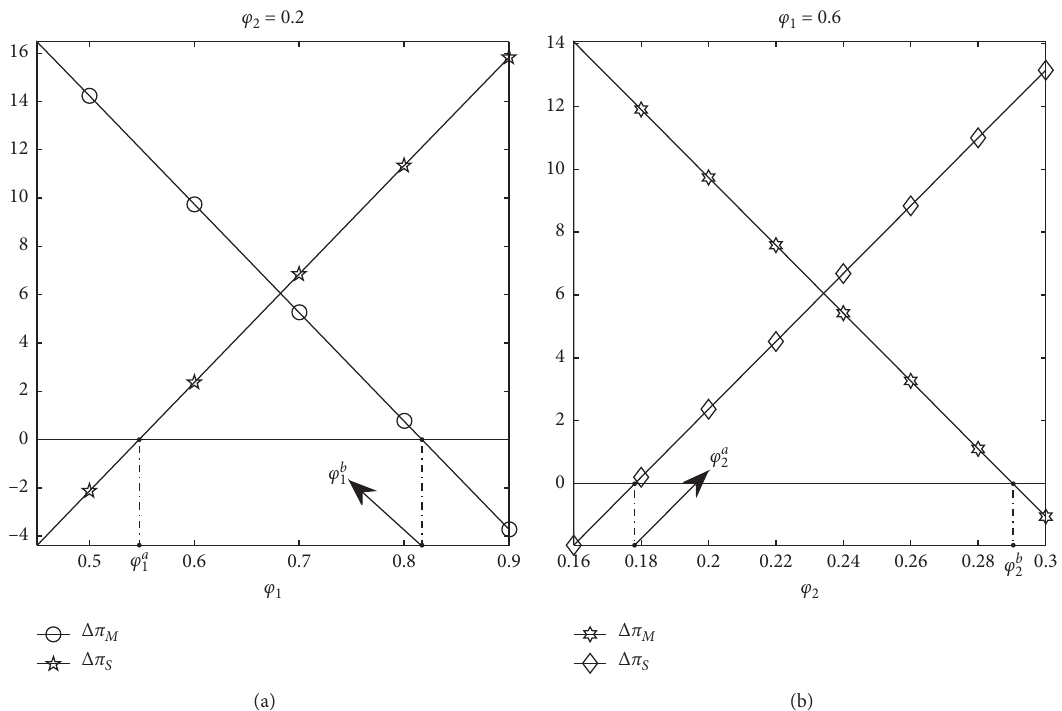
Figure 5: The impact of φ